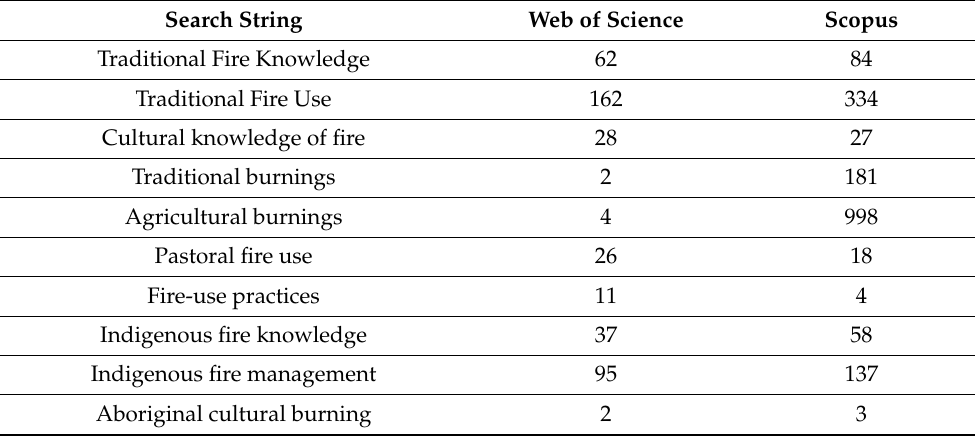
Table 2. Preliminary search of references on traditional fire knowledge before exclusion criteria. Search